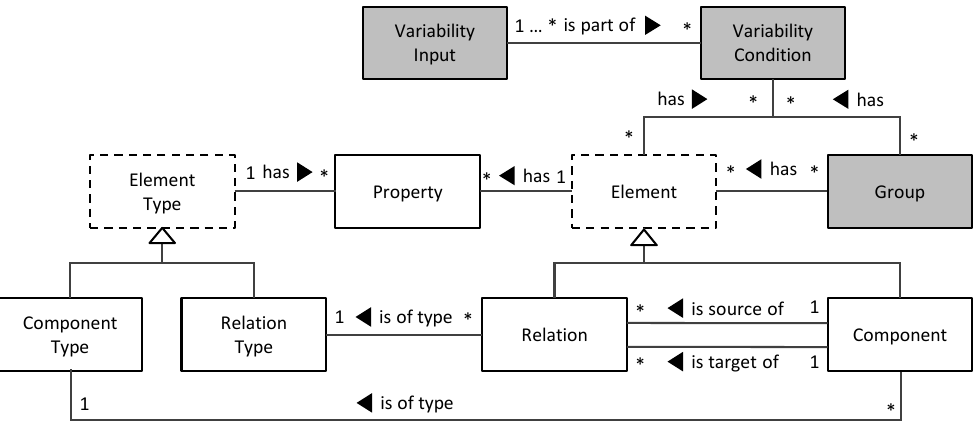
Figure 4. Class diagram of VDMM based on EDMM (EDMM original classes in white, added classes for variability in